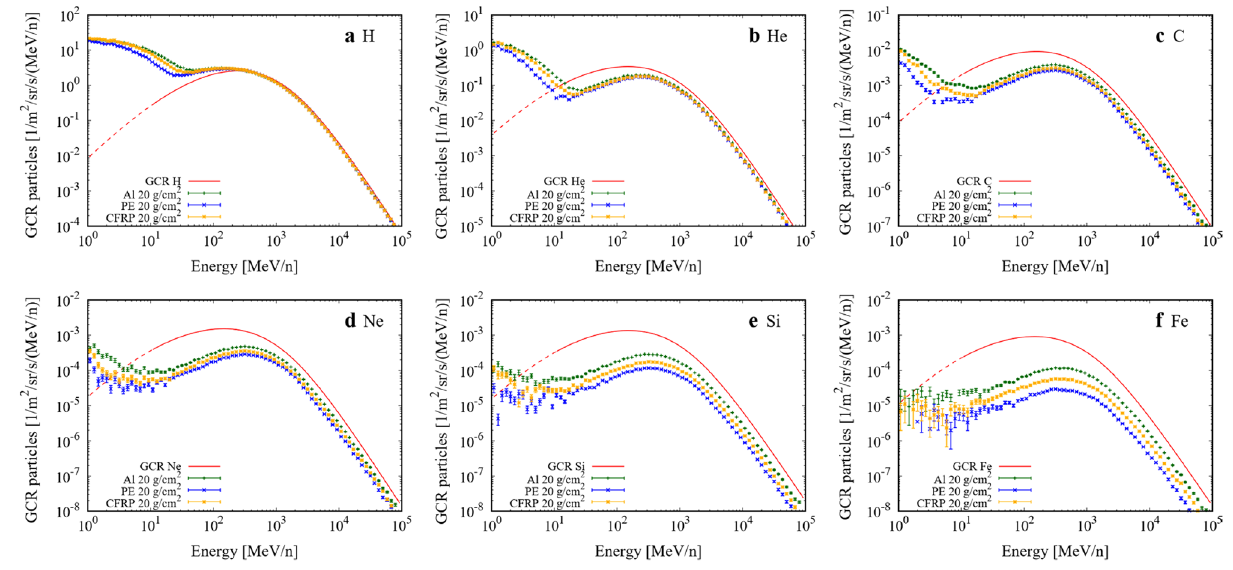
Figure 1. Energy spectra of GCR major elements in free space and with 20 g/cm 2 shielding. ( a ) H, ( b ) He, ( c ) C, ( d ) Ne, ( e ) Si, and ( f ) Fe. Red line denotes GCR primary element in free space. Green, blue, and yellow denote GCR element with 20 g/cm 2 shielding with Al, PE, and CFRP, respectively. Dotted energy regions (1–10 MeV/n) are not included in calculation primary sources because these low energy primary particles are stopped in a thin layer and do not contribute to the flux behind